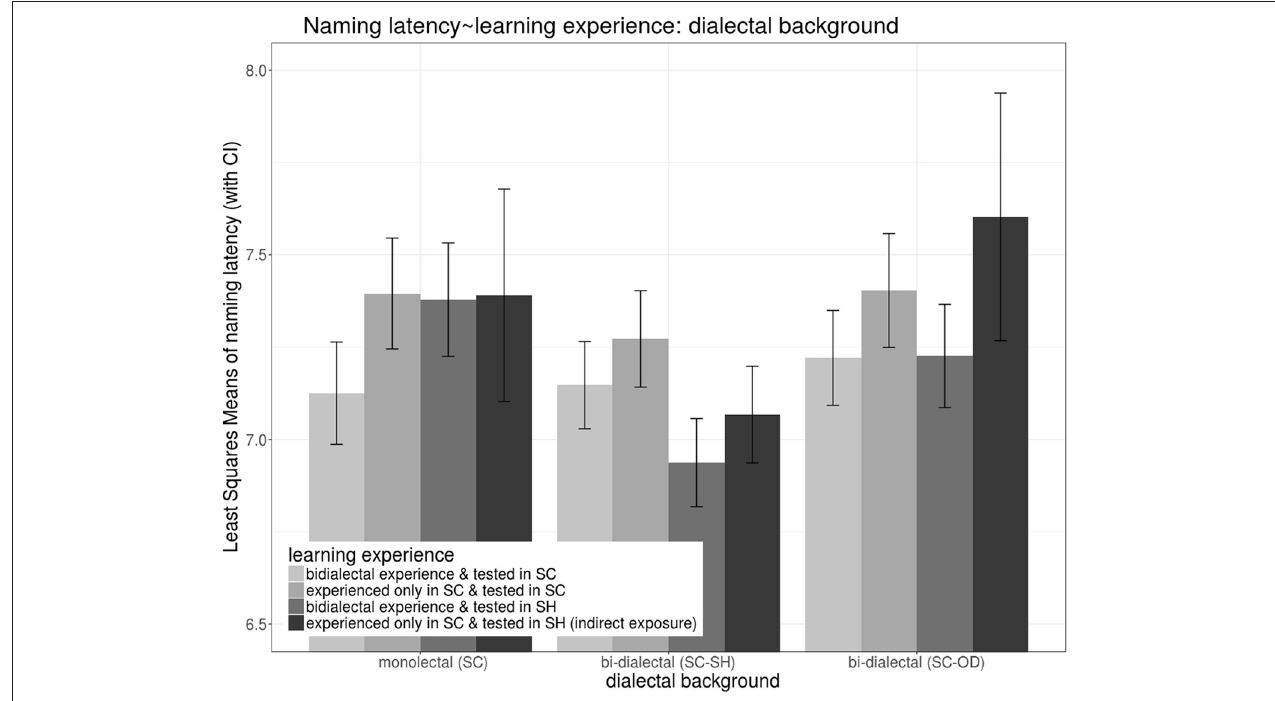
FIGURE 12 | Effects on naming latencies during the lexical production test, showing an interaction between learning experience (a combination of the participants’ exposure to target words prior to the naming task and language of operation in the naming task , color) and dialectal background